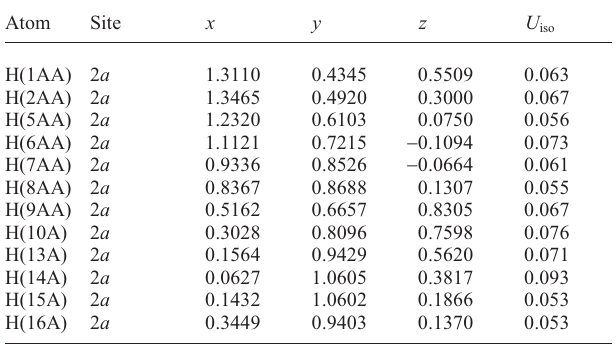
Table 2. Atomic coordinates and displacement parameters (in Å 2 )